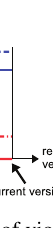
Fig. 1. Four change patterns of